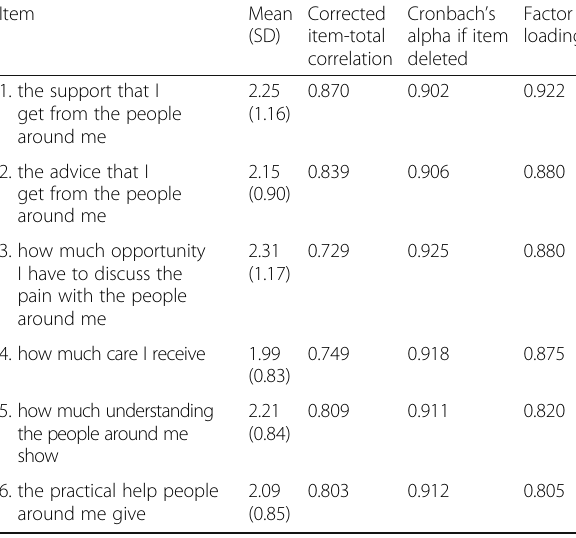
Table 3 Range, mean scores, corrected item-total